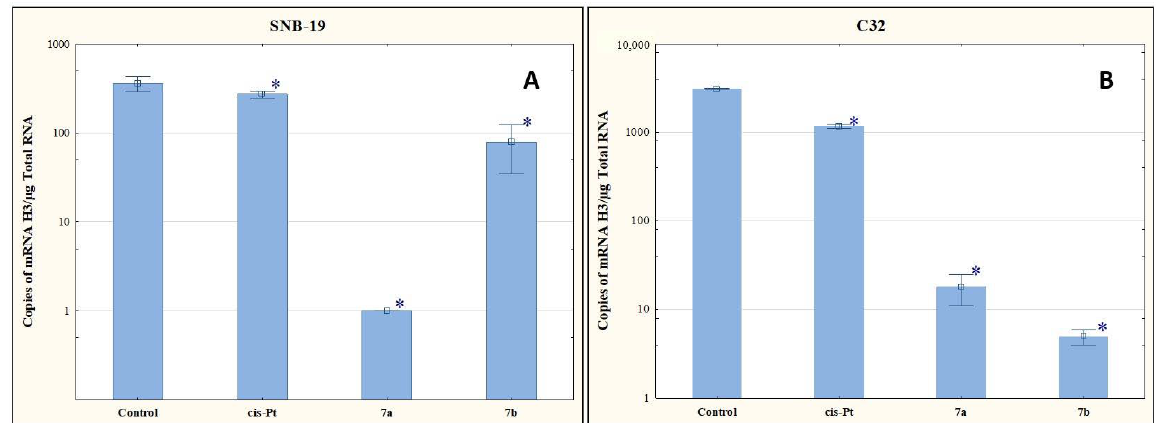
Figure 6. The effect of compounds 7a and 7b on transcriptional activity of H3 for SNB-19 ( A ) and C-32 ( B ) cells. Cells were exposed to compound 7a and 7b for 24 h at a concentration equal to half of IC 50 determined for SNB-19 (0.3 and 0.25 µ g/mL, respectively) and for C-32 (0.7 and 0.25 µ g/mL, respectively). For the reference compound, cisplatin, the appropriate concentrations were 0.8 µ g/mL (SNB-19 line) and 0.6 µ g/mL (C32 line). * p < 0.05 compared with the untreated